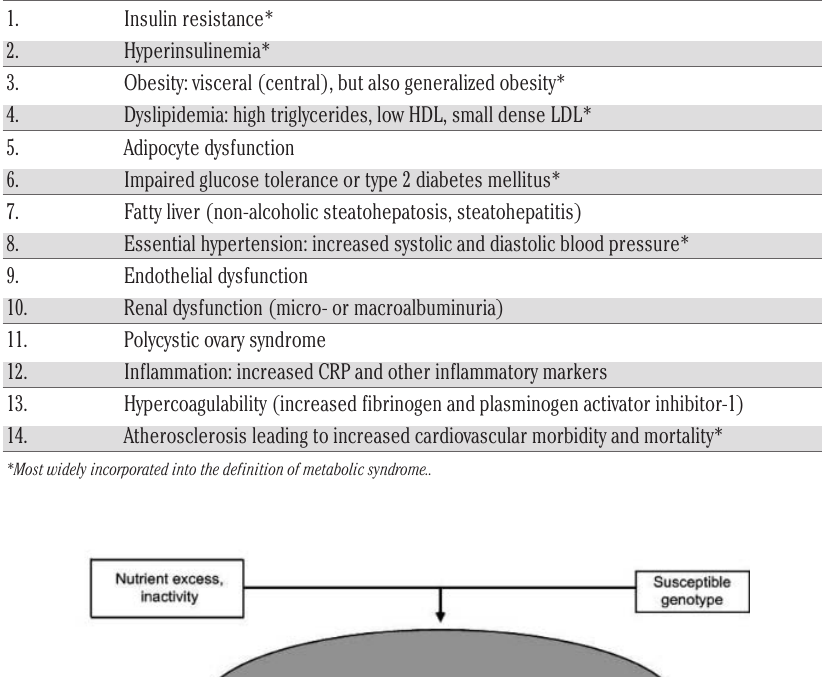
Table 4. Components of metabolic syndrome.